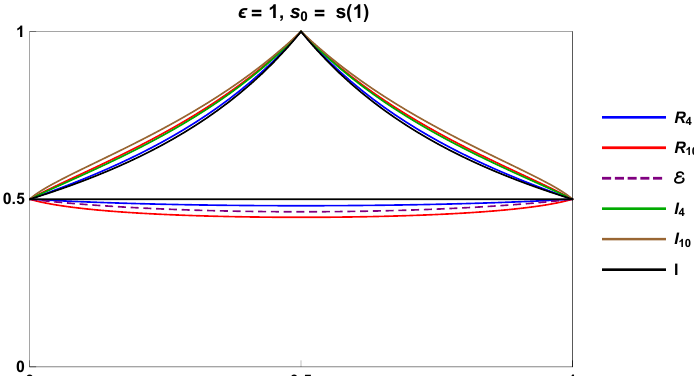
Figure 10 . Phase transition lines for R n and I n for n = 4 , 10 . The transition from NE to ES for E obtained from the semi-circle approximation is shown with the dashed purple line. The transition from the first to the second line of (4.28) for all Renyi mutual informations coincides with the black n = 1 transition line in this